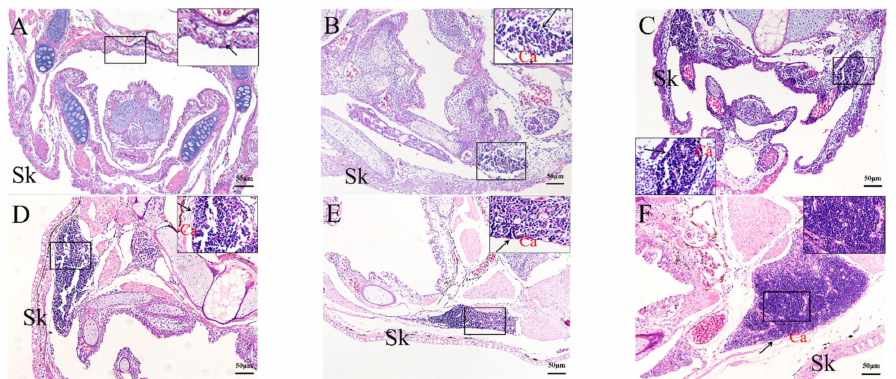
Figure 7. Hematoxylin and eosin staining of histological sections of the rice-field eel thymus from 2 dph to 45 dph. ( A ): 2 dph; ( B ): 6 dph; ( C ):10 dph; ( D ):17 dph; ( E ): 30 dph; ( F ): 45 dph. Bars: 50 µ m. Black arrow: thymus. Ca: capsula. Sk: skin. Sections were stained with HE.